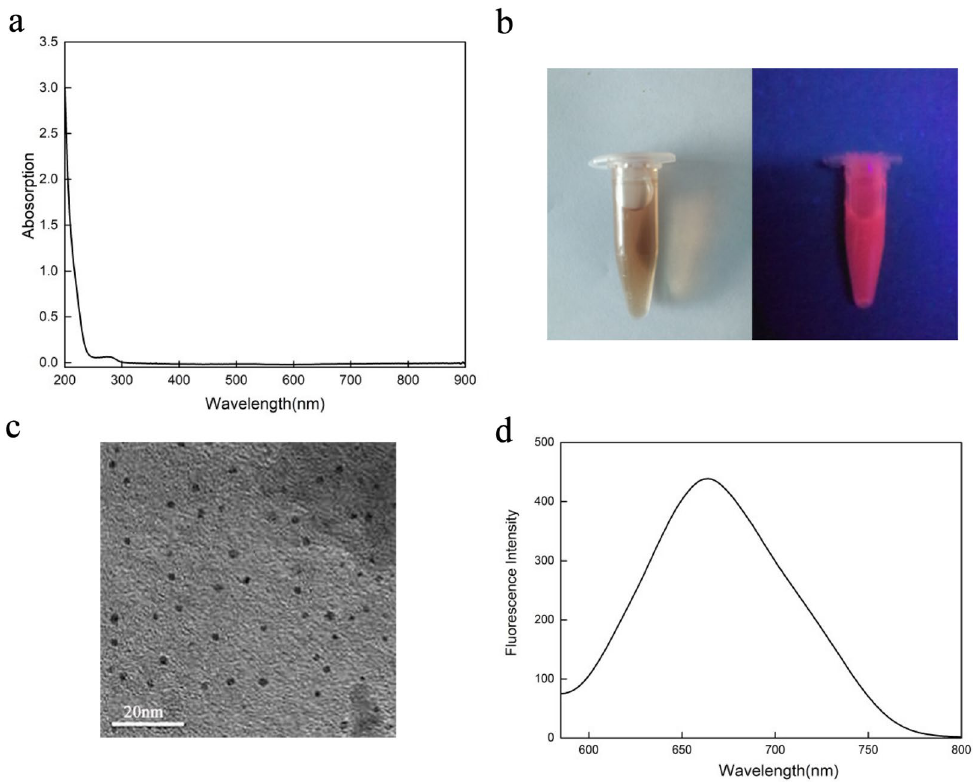
Figure 1. Characterization of the AuNCs: ( a ) UV–visible absorption spectrum of the AuNCs, ( b ) The photographs of the AuNCs (The photograph on the left is in daylight, The photograph on the right shows a 350 nm UV lamp), ( c ) The TEM photograph of the AuNCs, ( d ) Fluorescence emission spectra of AuNCs at an excitation wavelength of 260